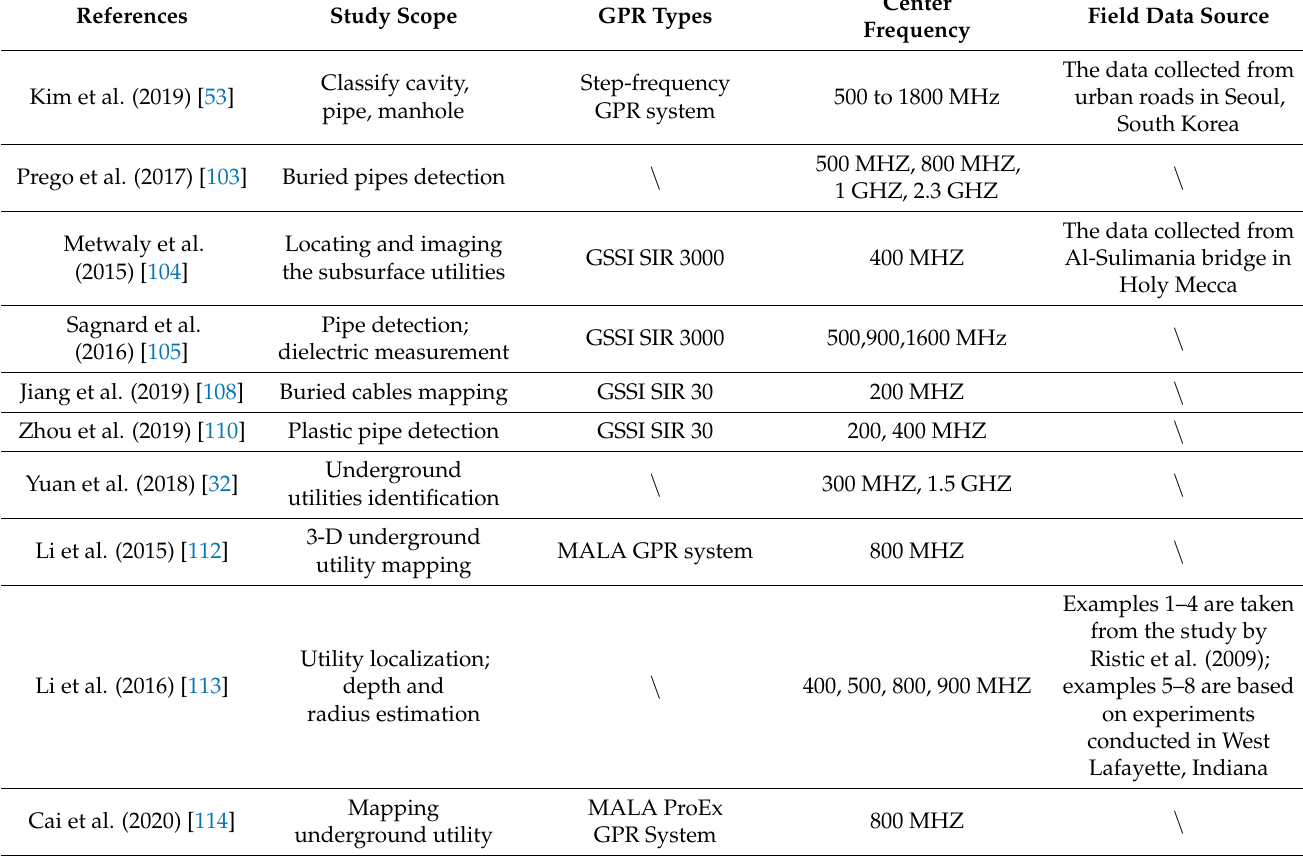
Table 3. Some examples of the latest GPR works in mapping underground